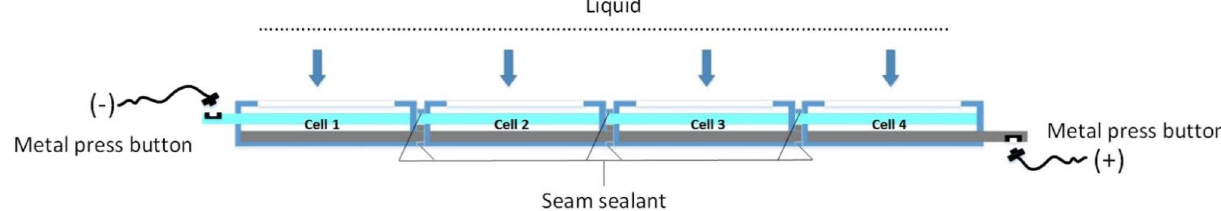
Fig. 2 Multi-cell battery design, side